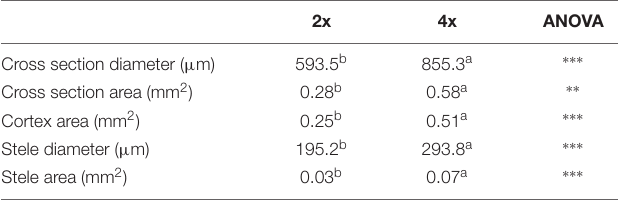
TABLE 3 | Root cross section parameters of the 2x and 4x CC seedlings cultured in vitro measured at 20 mm from root apex.